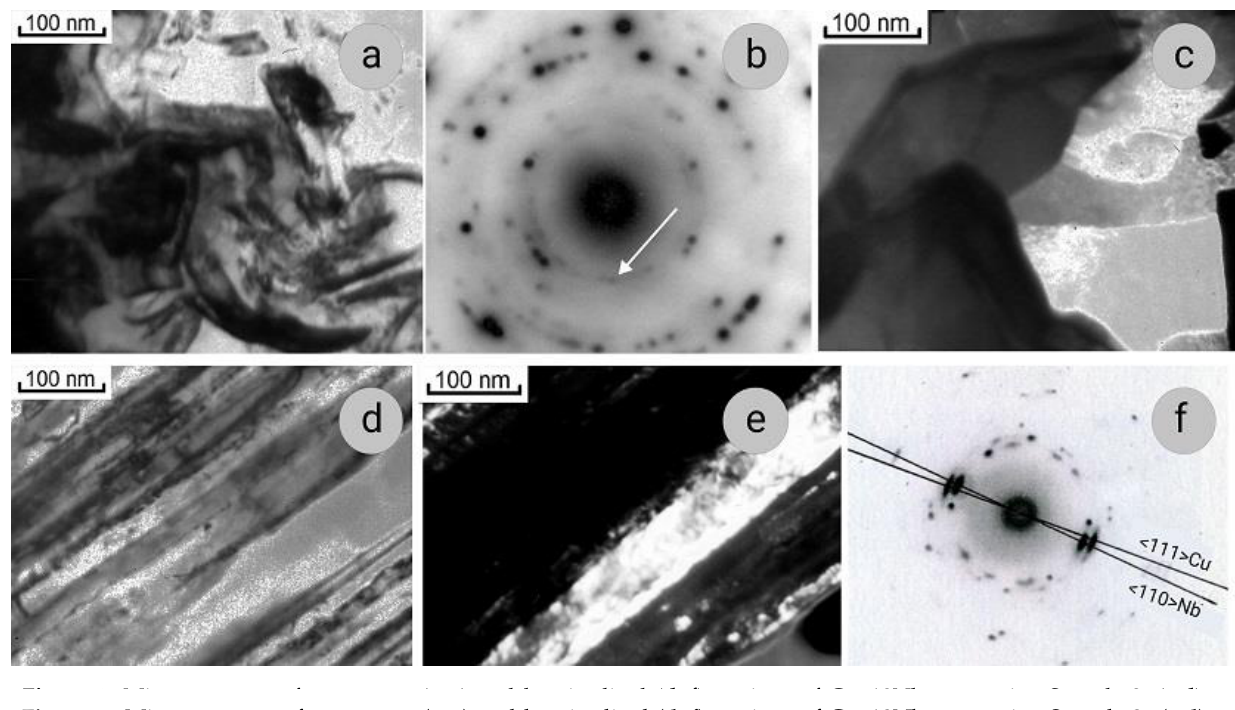
Figure 2. Microstructure of transverse section of Cu – 18Nb composite, Sample 1: ( a ) — bright-field image; ( b ) — dark-field image in (220) Cu reflection; ( с ) — SAED, zone axis [112] Cu.